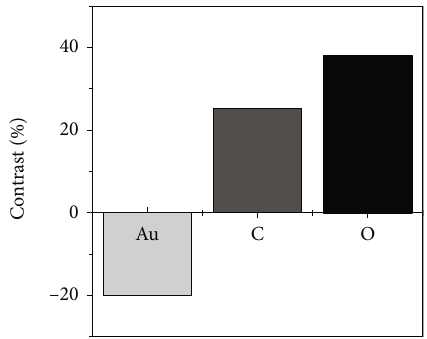
Figure 3: Contrast diagram, comparing the Au4f, C1s, and O1s photoelectron intensities measured at 90 ° and 30 ° detector angle for a CCC sample. The contrast is de fi ned in Equation